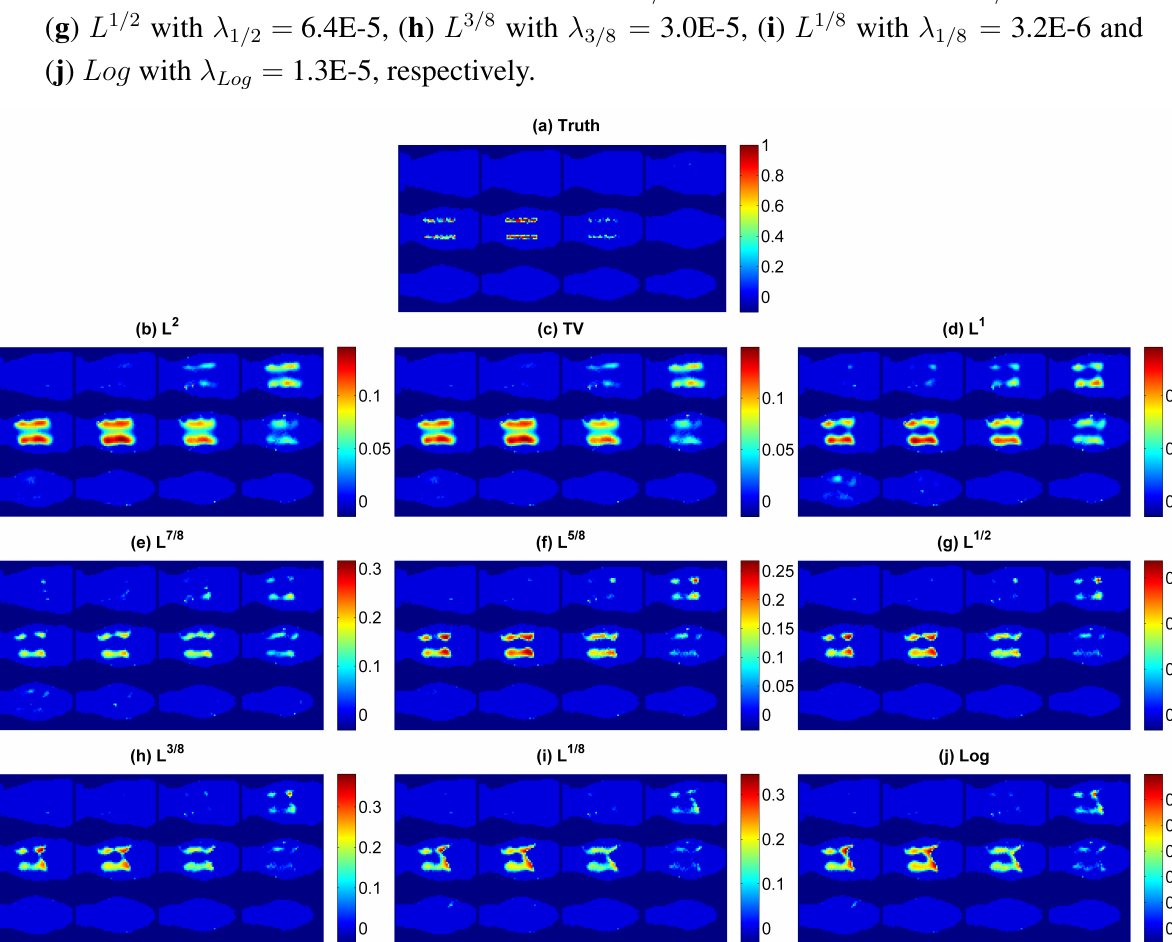
= TV = 1.0E-4, 5 / 8 = 3.2E-6 and 1 / 8